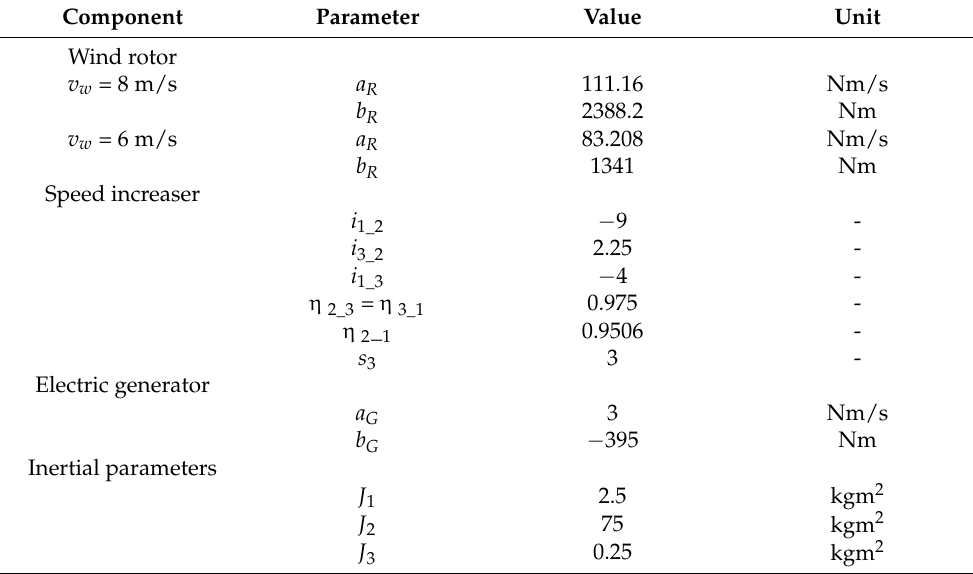
Table 1. The parameters of the 10 kW wind turbine with counter-rotating